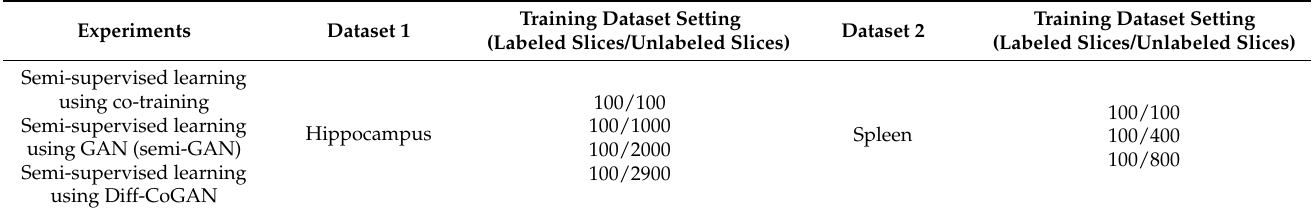
Table 2. The training dataset settings. The labeled slices in both Dataset 1 and Dataset 2 were set to 100 slices in all experiments. Meanwhile, the unlabeled slices were varied to investigate how this affected the segmentation